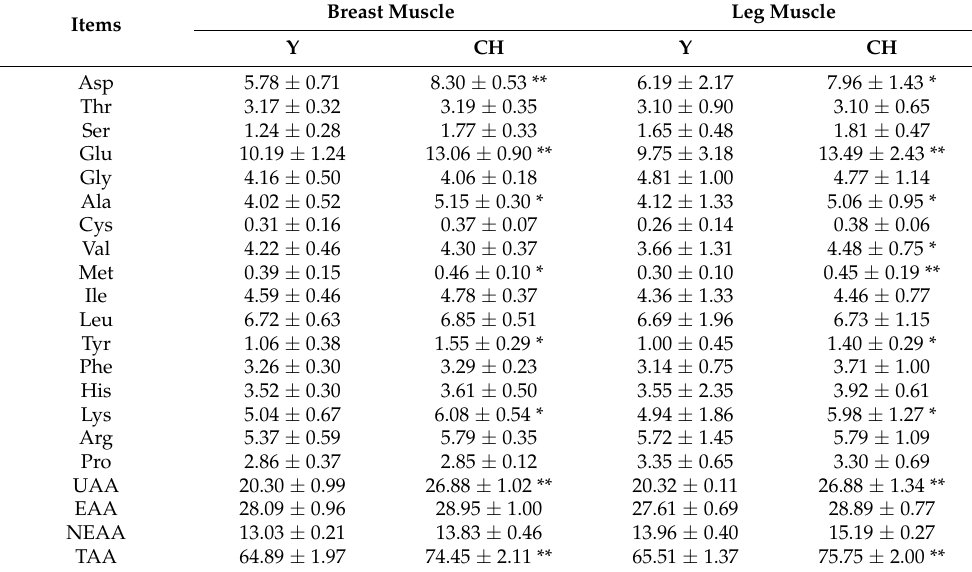
Table 3. Amino acid content in muscles of